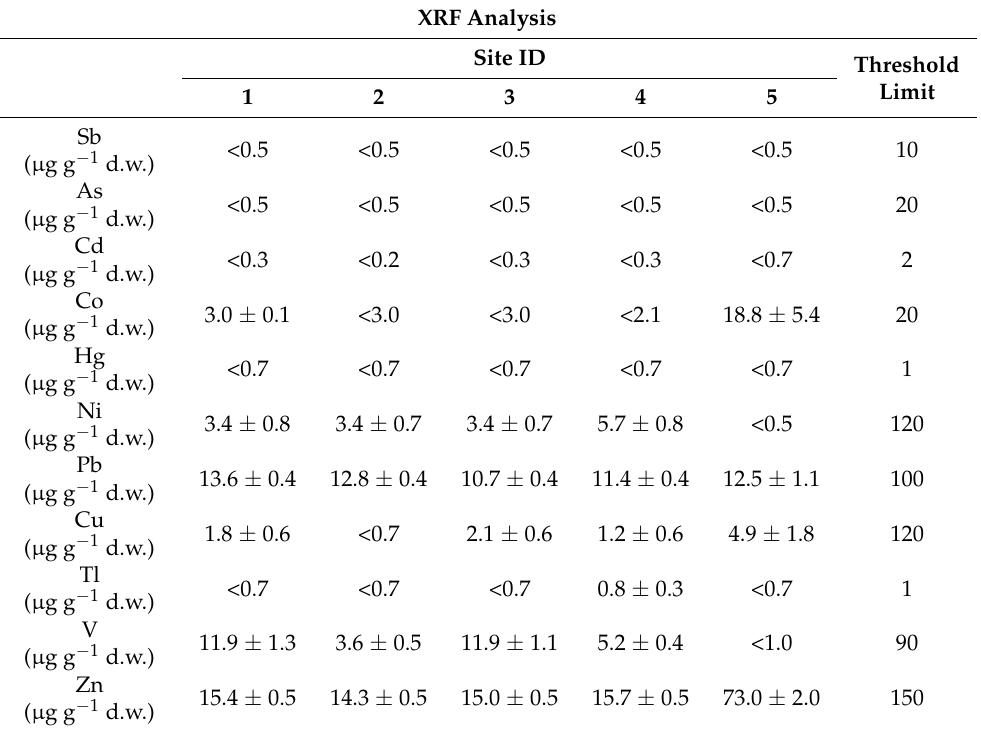
Table 4. Heavy metals content ( µ g g − 1 d.w.) for the analysed sands, as obtained through XRF analysis.